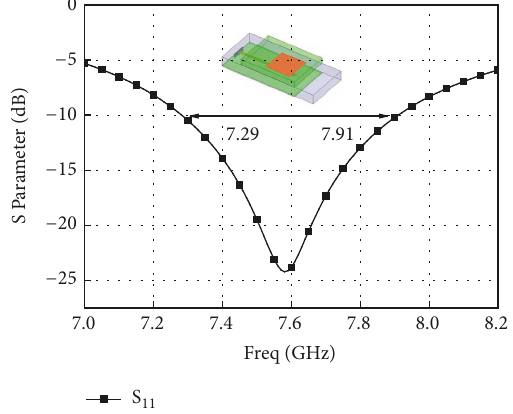
Figure 3: Return loss of the cell antenna.